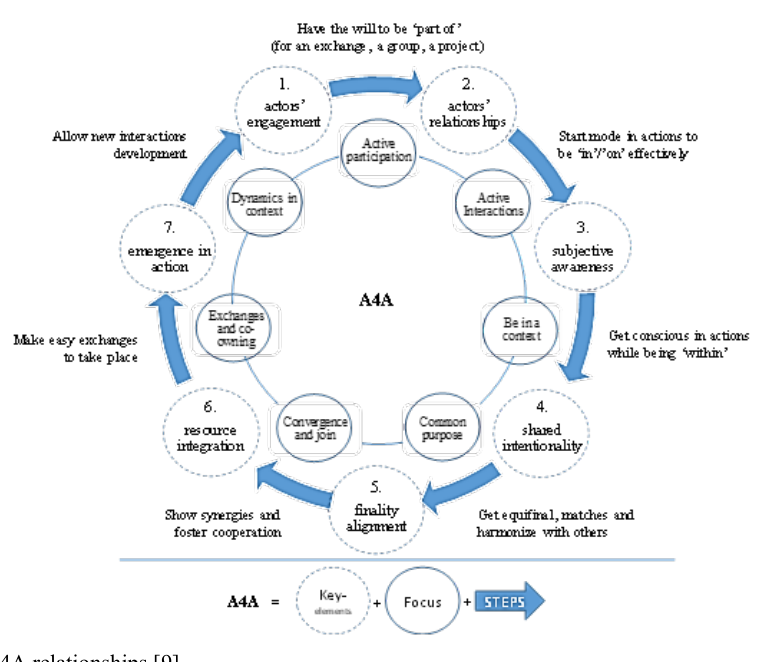
Fig. 1. A4A relationships